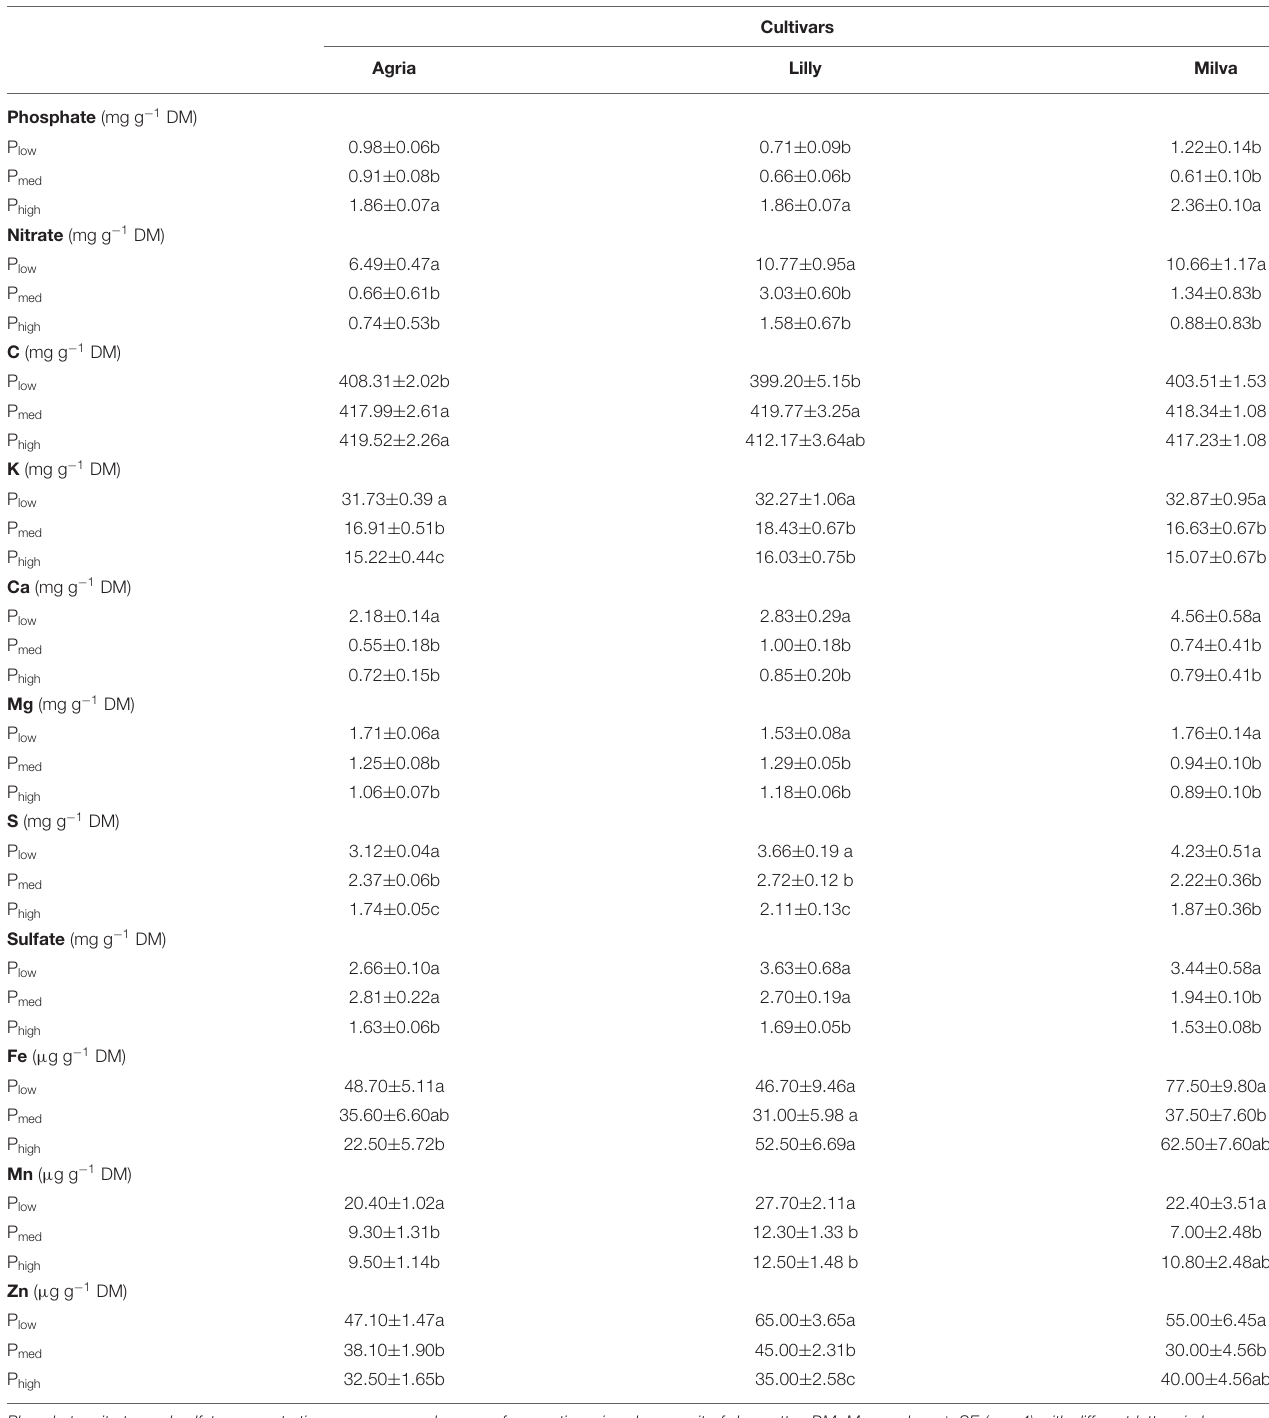
TABLE 2 | Tuber mineral and ion concentration of potato cultivars with P low , P med , and P high . Cultivars Agria Lilly